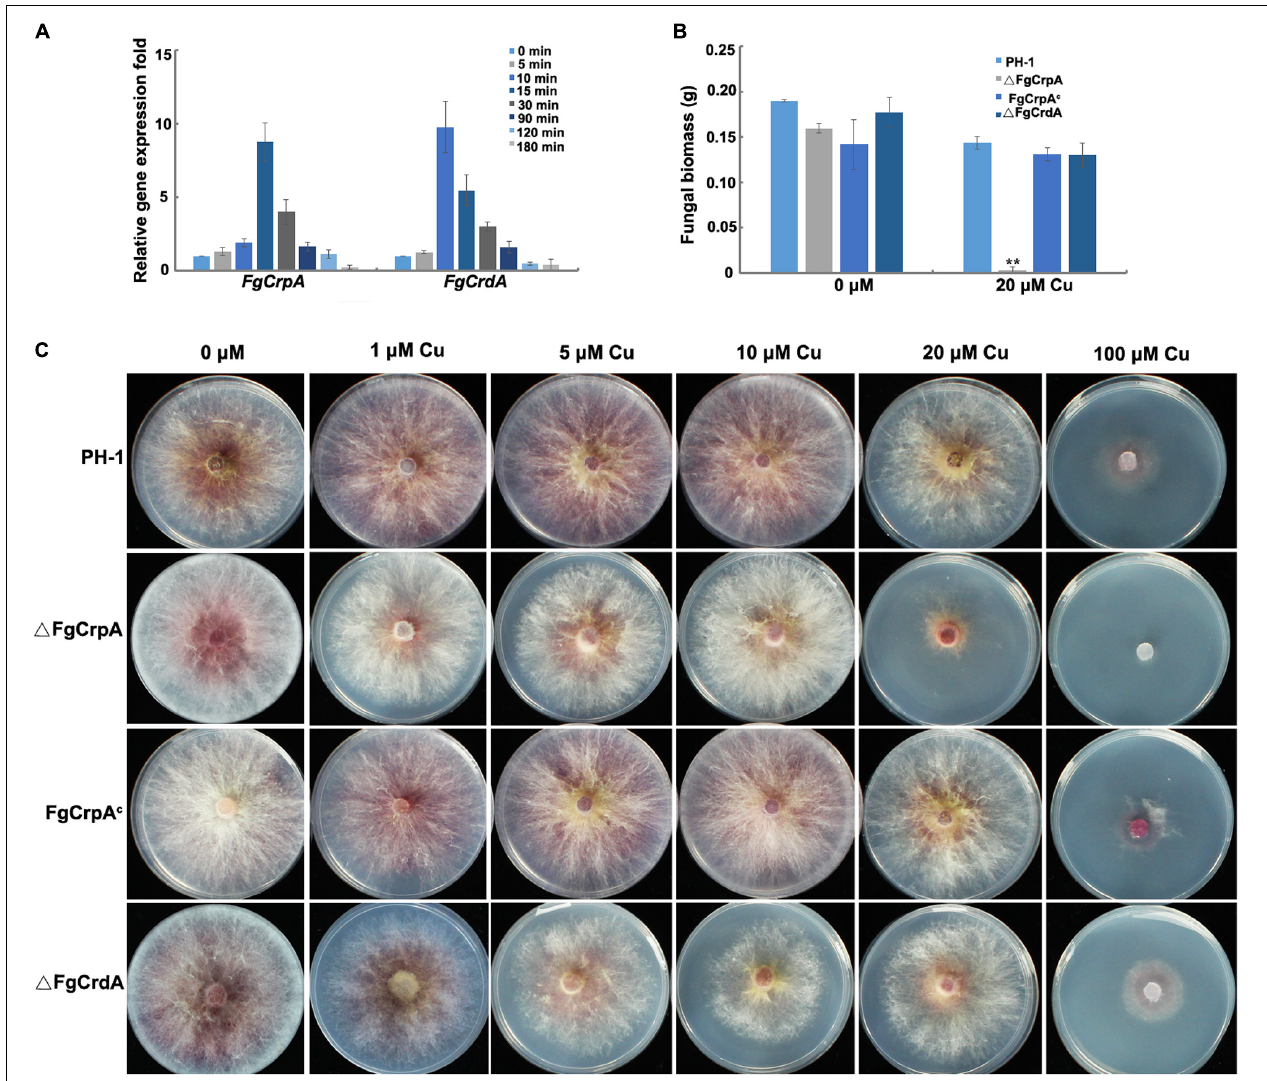
FIGURE 1 | FgCrpA and FgCrdA were induced by Cu treatment and their roles in Cu detoxification. (A) Expression of FgCrpA and FgCrdA in F. graminearum after Cu treatment analyzed by quantitative Real-time PCR assays. The wild-type strain PH-1 was grown in liquid FMM (Cu free) for 3 days at 25 ◦ C and then collected, washed using sterile water and transferred to liquid FMM supplemented with CuSO 4 at 100 µ M for different time courses. (B) Fungal growth was measured by determining the dry weight of the wild-type strain and mutants grown in 50 ml liquid FMM amended with or without CuSO 4 at 20 µ M in a shaker at 180 rpm at 25 ◦ C for 3 days. Bars indicated means and error bars denote standard deviation from three repeated experiments. A t -test was performed to determine significant differences, ** p < 0.01. (C) Phenotypic characterization of (cid:77) FgCrpA, FgCrpA c , and (cid:77) FgCrdA under Cu stress, equal numbers of conidia (2 × 10 3 ) were spot inoculated onto solidified FMM amended with CuSO 4 at different concentrations indicated in the figure and cultured at 25 ◦ C for